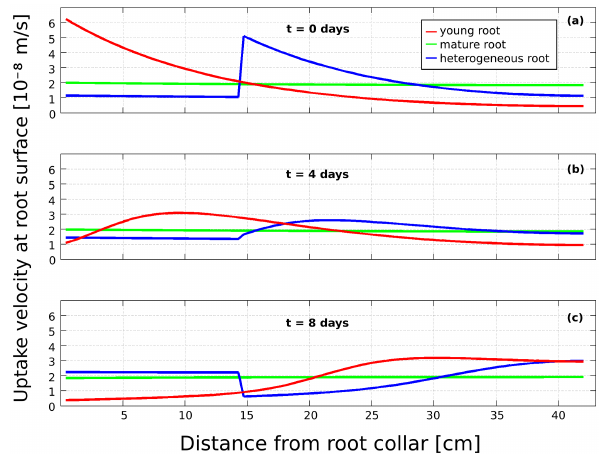
Figure 6. Velocity of radial inflow (uptake velocity) at the root sur- face along three unbranched single roots with equal length ( l total = 0 . 42m) but different composition. Values are obtained with the sim- ple model for roots containing young roots only (red), mature roots only (blue) or an optimal mixture with respect to water yield (green; l mature = 0 . 14m, l young = 0 . 28m). Results are depicted for (a) ini- tial stage (hydrostatic equilibrium), (b) 4 days and (c) 8 days of simulation time.